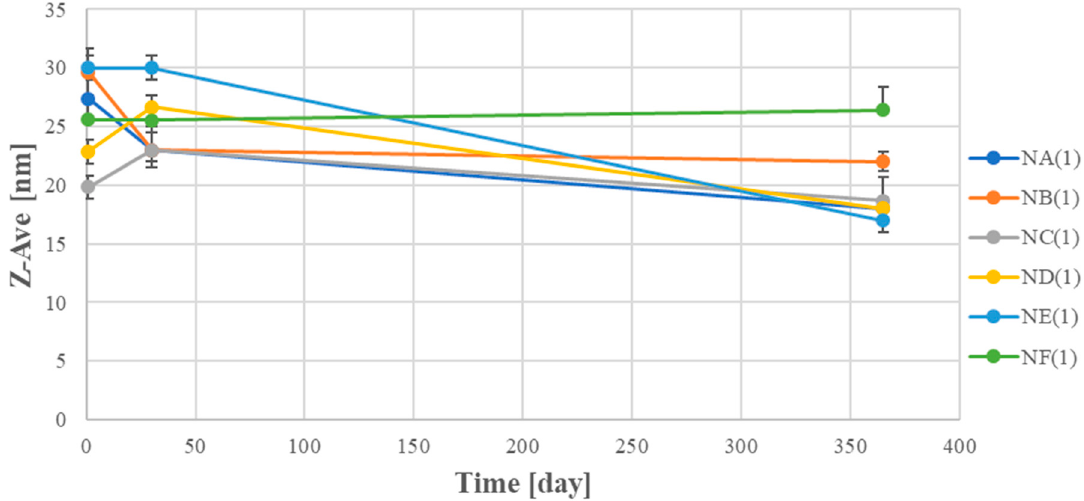
Figure 3. Droplet sizes of the nanoemulsions on the basis of A–F compositions as a time function (S:O = 0.625: 0.375) (SD, n = 3).